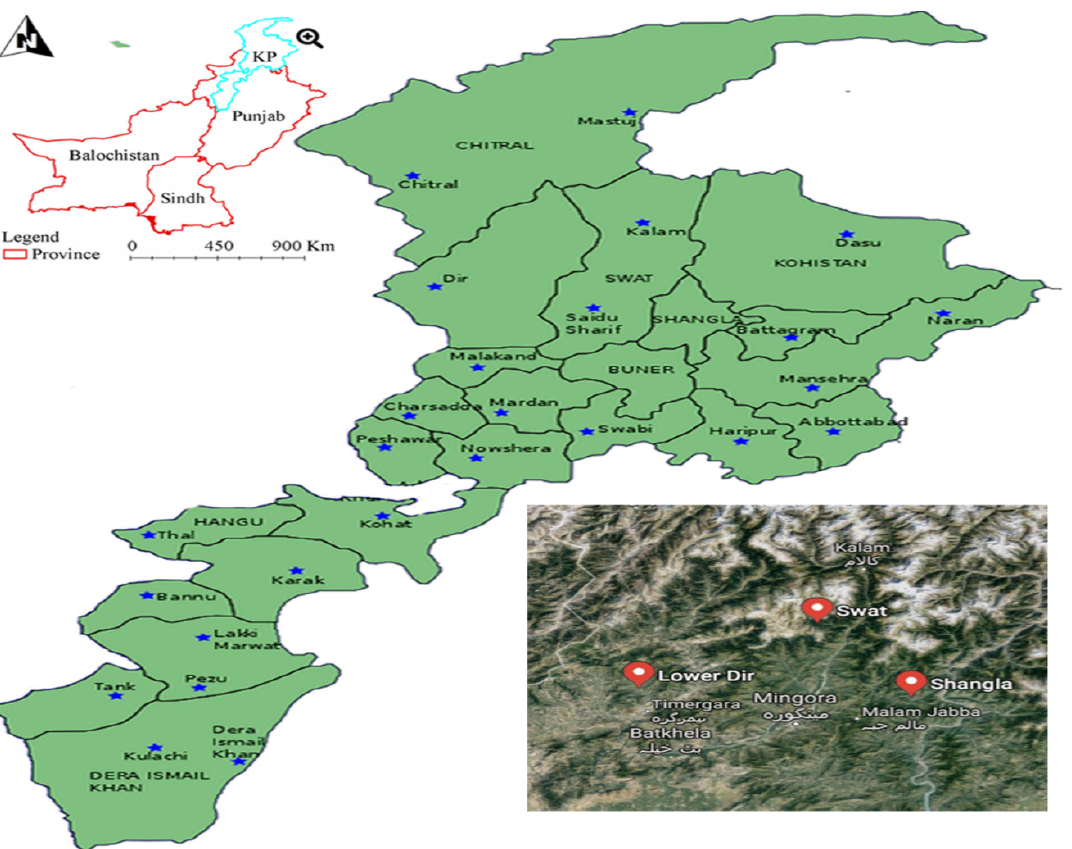
Figure 1. Map of the study area (Khyber Pakhtunkhwa Province (KPK)).